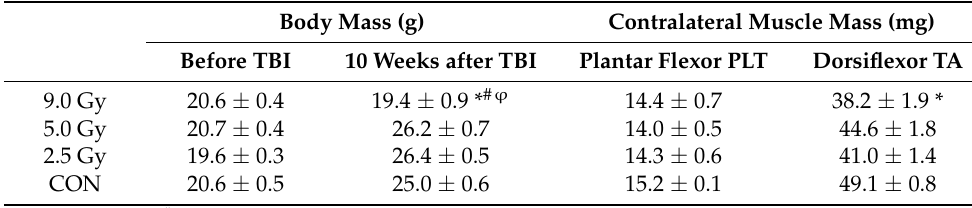
Table 1. Basic data of body and muscle mass after